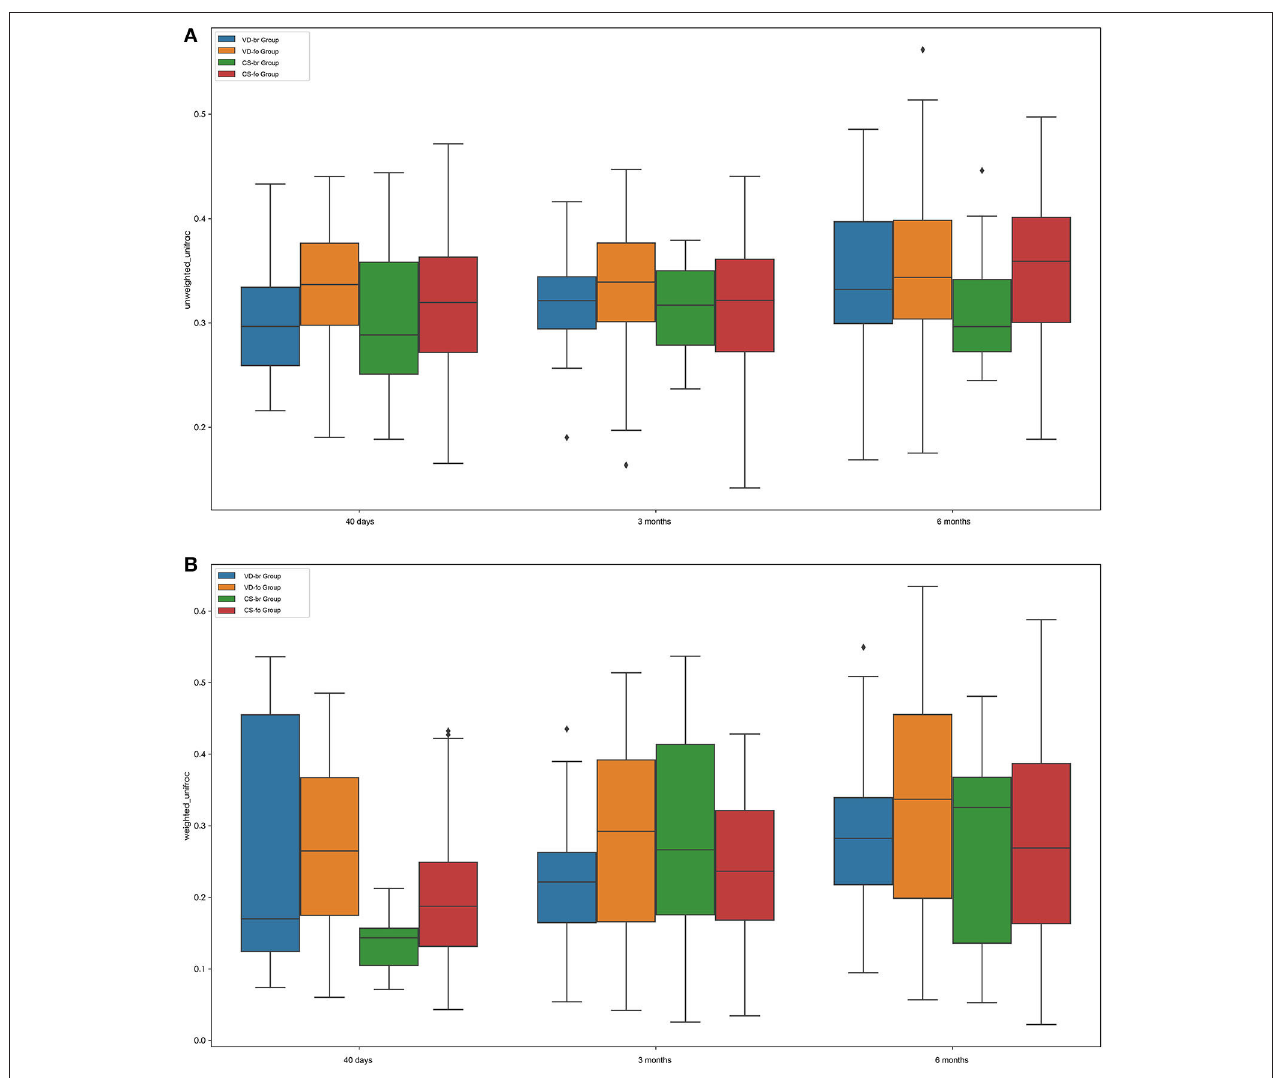
FIGURE 2 | β diversity measurements by Unweighted UniFrac (A) and Weighted UniFrac (B) . Boxplots compare β diversity of gut microbiota in 40 days (40 d), 3 months (3m), and 6 months (6m) of age among different groups. Boxes show 25th − 75th percentiles and the median line, and whiskers indicate minimum to maximum values. Statistical significance was evaluated by a two-tailed t test, using p ≤ 0.05 as the measure of